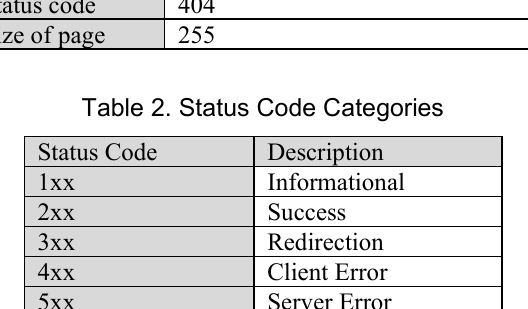
Table 5. URLs Address Assigned to A Numeric